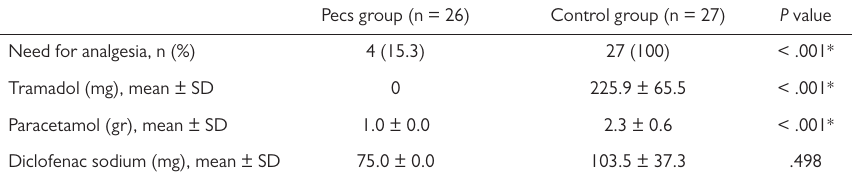
Table 3. Comparison of Perioperative Analgesic Consumption of